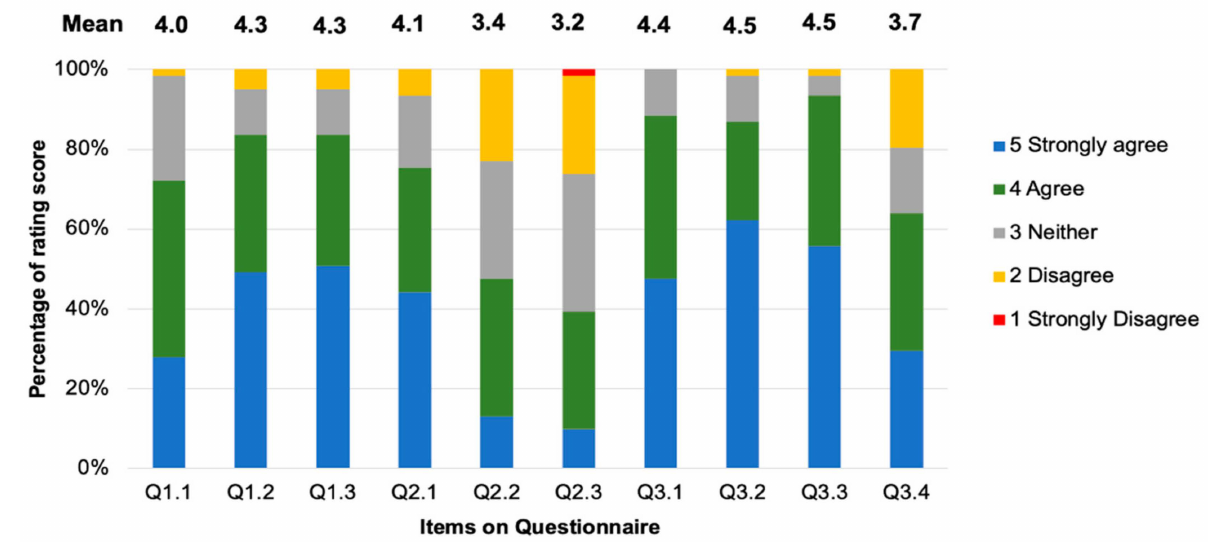
Figure 5. Percentage of each answer for each item on the questionnaire assessing the use of the 3D-printed